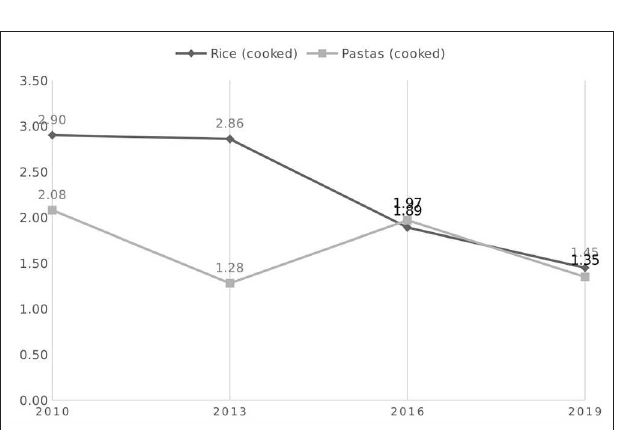
FIGURE 4 | Measured annual waste of cooked rice and pasta in collected household food waste in the Netherlands before 2010 and after the introduction of the measuring cup in 2013, 2016, and 2019, in kg per